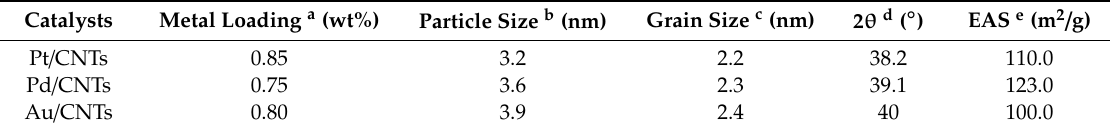
Table 1. Structural parameters for Pt / CNTs, Pd / CNTs, and Au / CNTs catalysts measured by ICP, TEM, XRD, and